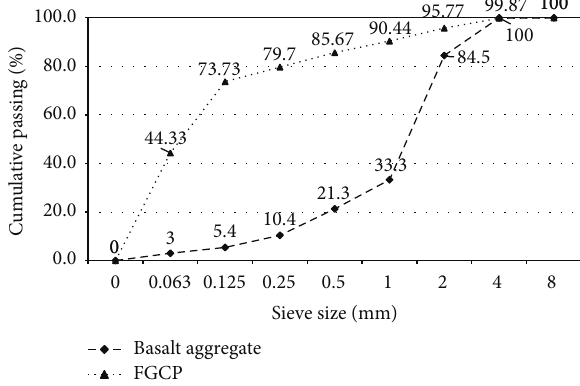
Figure 3: Granularity of used fine grounded ceramic powder and used basalt aggregate.